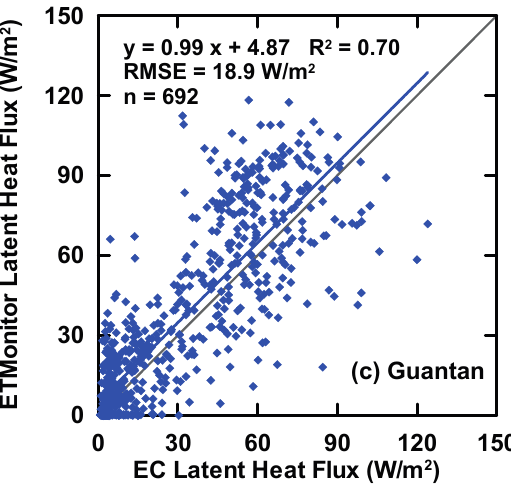
Figure 4. Scattering plots of the ETMonitor latent heat flux ( λ E) against eddy covariance (EC) observations spanning 2009–2011 at the site of ( a ) Yingke (cropland), ( b ) A’rou (alpine meadow), and ( c ) Guantan (forest). Values shown are the daily values of latent heat flux, λ E (W/m 2